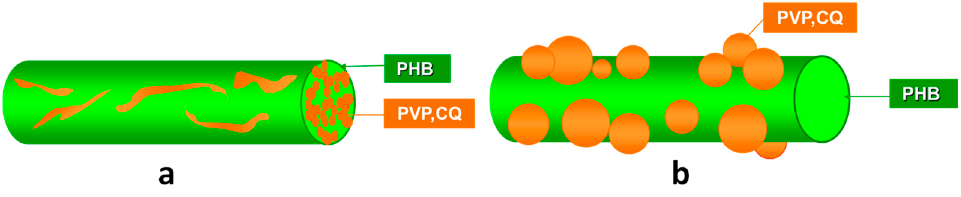
Figure 3. Schematic representation of fibers: ( a ) PVP in PHB fiber containing CQ in the bulk (PVP,CQ in PHB) and ( b ) PHB fiber decorated with PVP,CQ particles on the surface (PVP,CQ on PHB) [99].